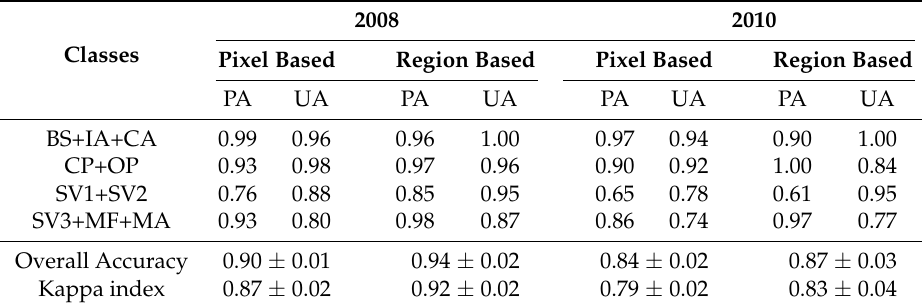
Table 8. Mean accuracy values of land cover classes of L2 based land cover classifications.